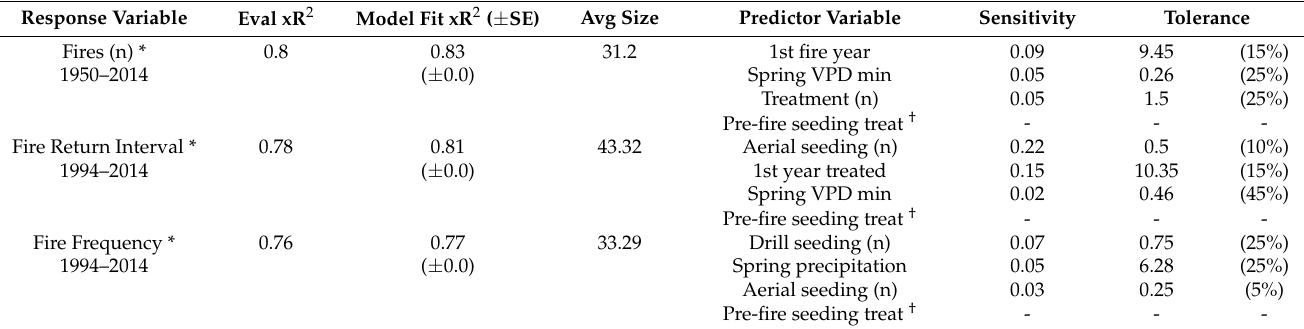
Eval xR2 = The correlation from original model analysis. Model Fit xR2 = Correlation based on the bootstrap analysis. Avg. Size = The number of sample units contributing to the estimate of occupancy. * p < 0.01, SE = Standard error. † Categorical variable. Sensitivity and tolerance can only be calculated with continuous